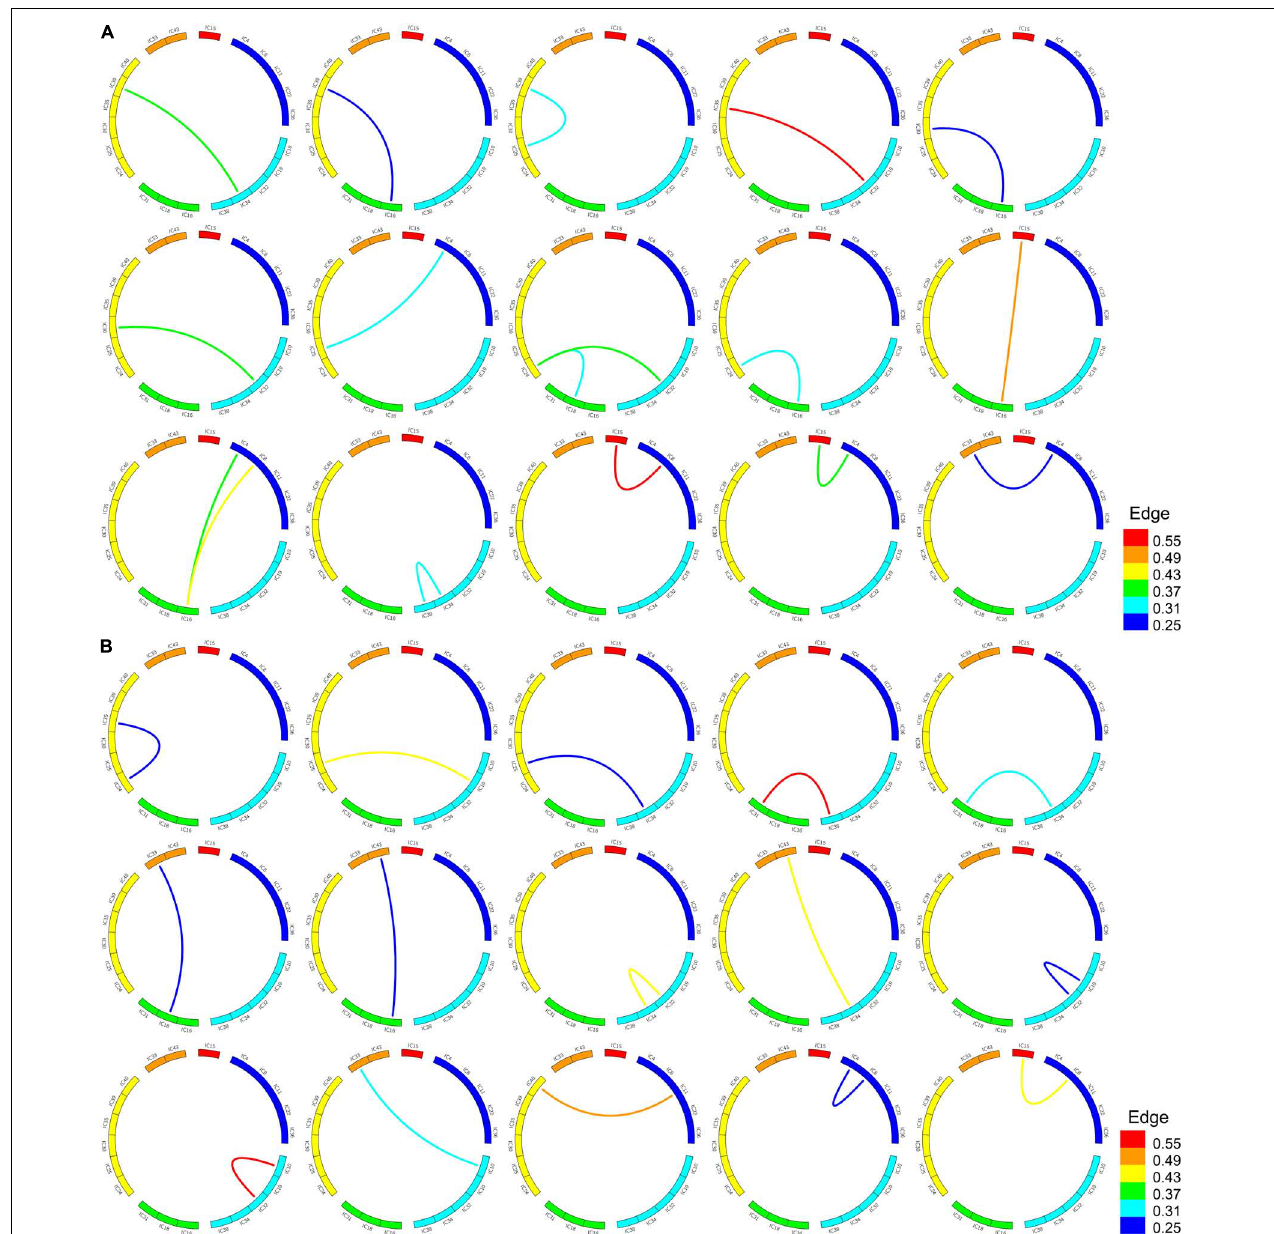
FIGURE 3 | Frequent subgraphs of MDD and NC group. (A) Represent top 15 discriminative subgraphs in MDD group. Edge refers to the edges are assigned with a probability of existence in MDD group. (B) Represent top 15 discriminative subgraphs in NC group. Edge refers to the edges are assigned with a probability of existence in NC